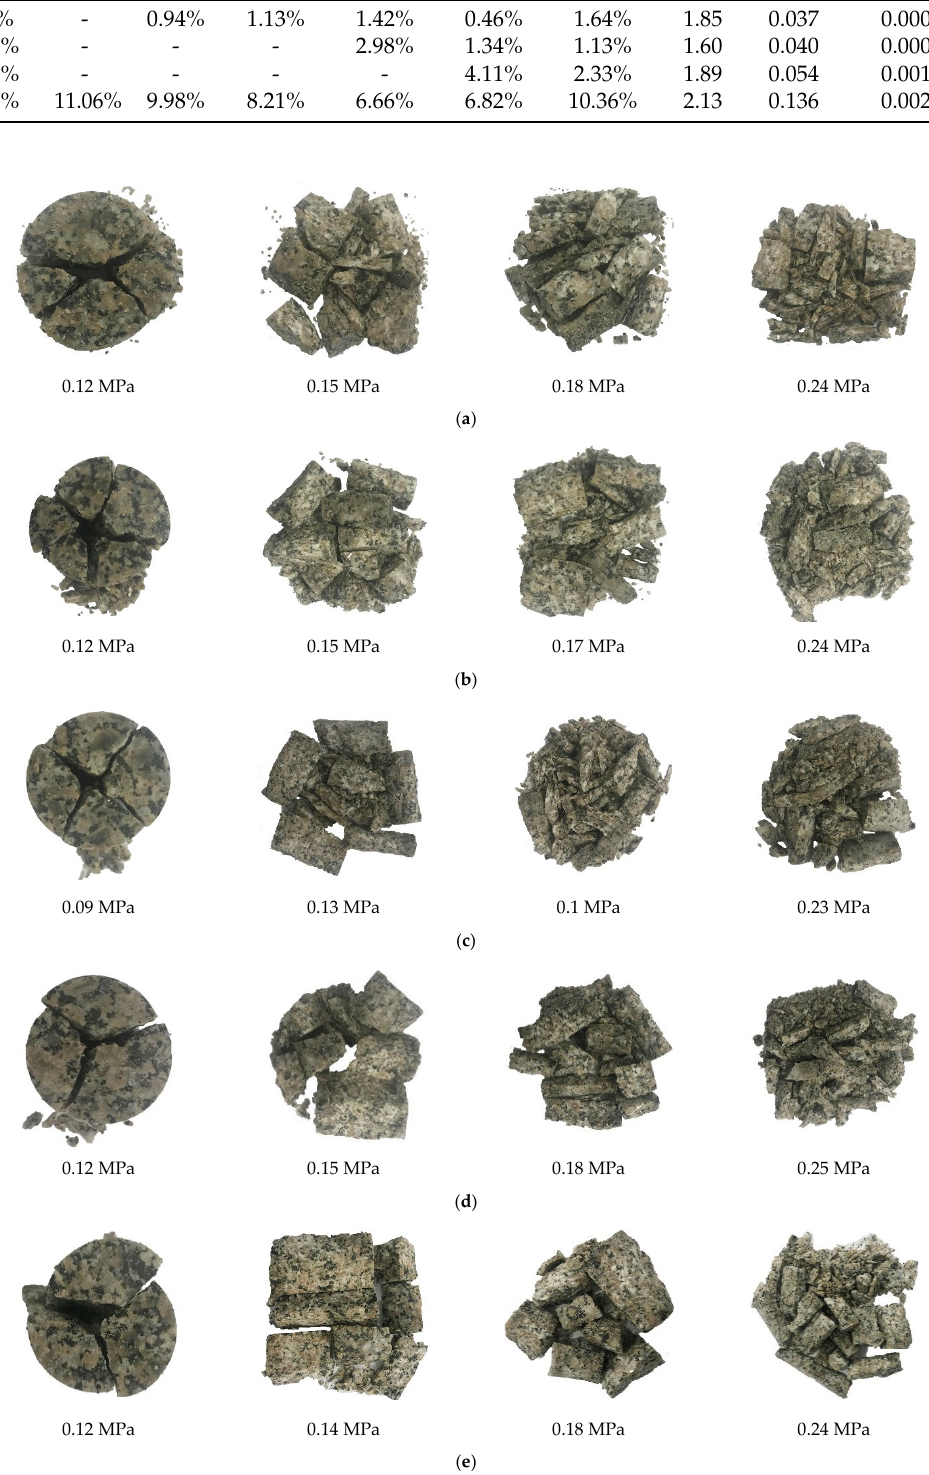
Figure 9. Damage pattern of granite specimen at different air pressures: ( a ) aspect ratio is 0.6; ( b ) aspect ratio is 0.8; ( c ) aspect ratio is 1.0; ( d ) aspect ratio is 1.2; ( e ) aspect ratio is